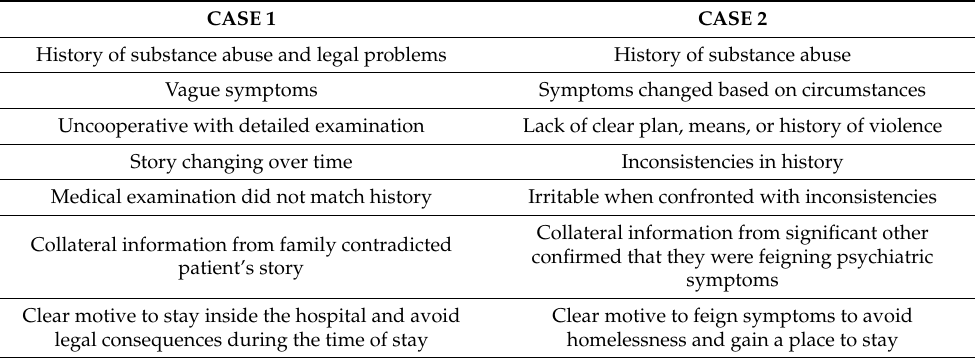
Table 1. Summary of pertinent findings in the two cases that point towards a possibility of feigned homicidal